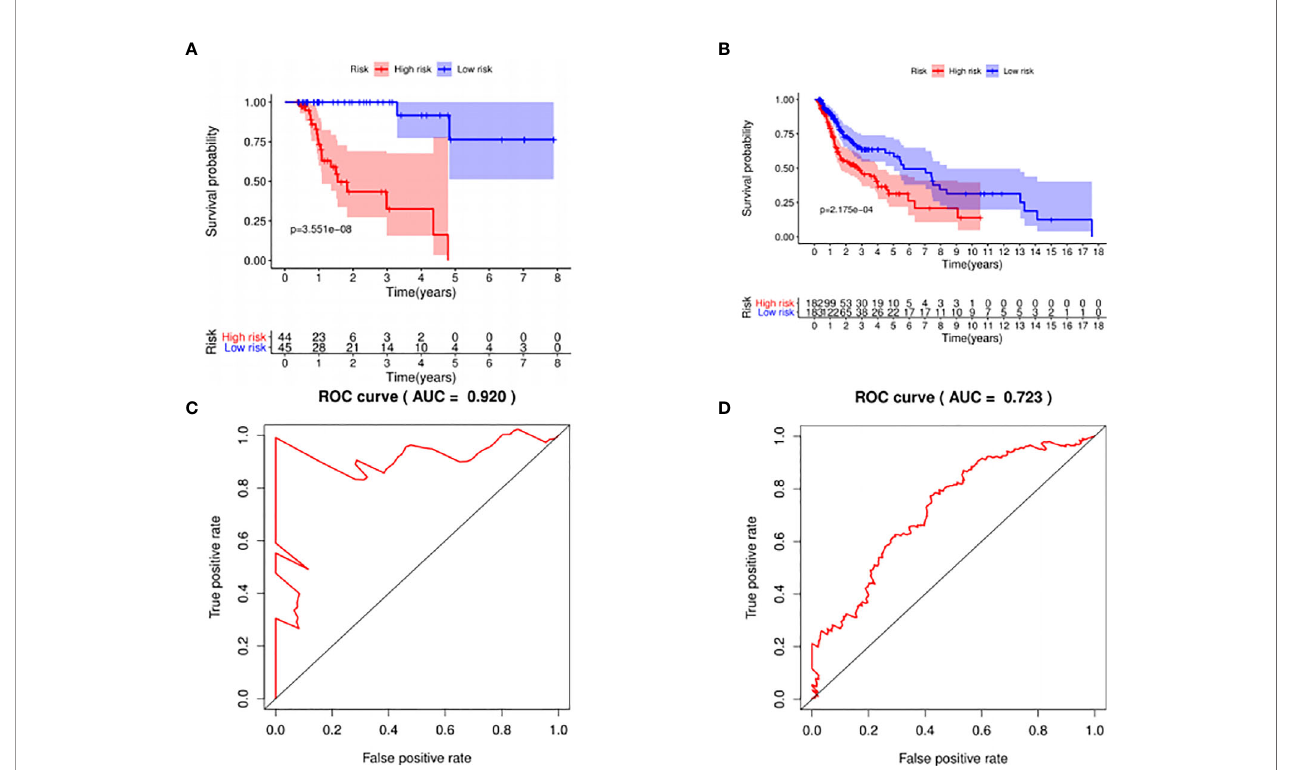
FIGURE 4 | The prognostic value of the signature. HPV+ group: (A) and (C) ; HPV- group: (B) and (D) . (A, B) : The overall survival curve of high risk score group and low risk score group. (C, D) : Receiver operating characteristic curve of the 5-year survival estimated via risk